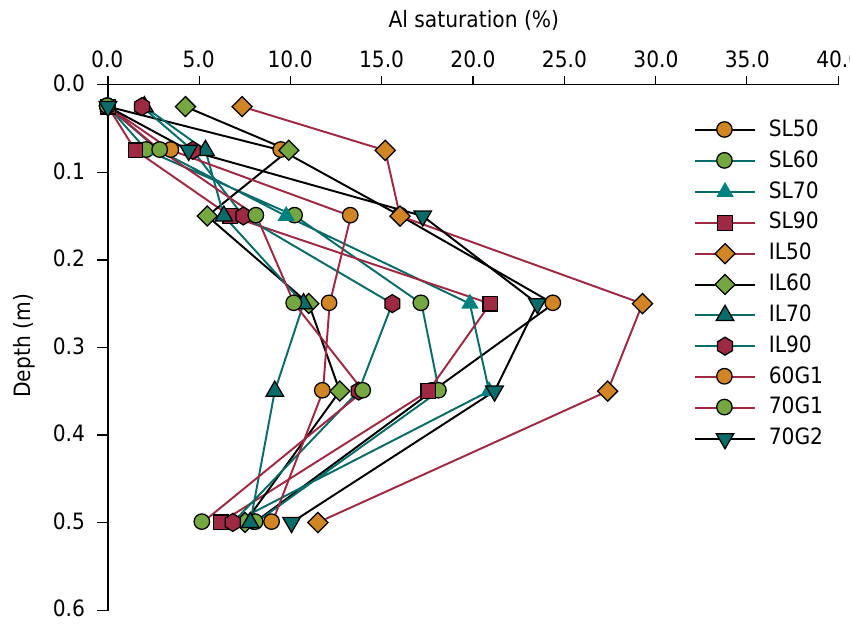
Figure 3. Saturation by aluminum (m%) at different depths 48 months after application of lime. Soils were limed to different base saturation (BS) levels (50, 60, 70, and 90 %) by surface application (SL) or lime incorporation (IL) or treated by surface application of lime (60 and 70 % BS) and a standard (G1) or double (G2) dose of phosphogypsum as 60G1, 70G1, and